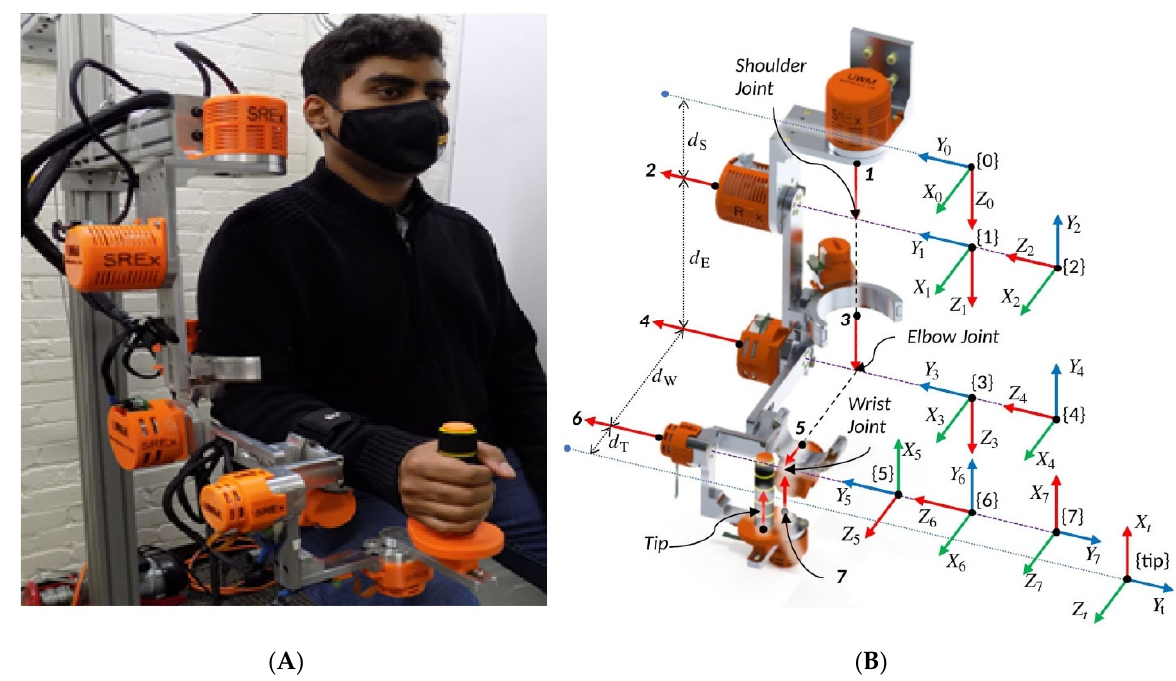
Figure 2. ( A ) SREx maneuvered by a healthy subject. ( B ) Link frame assignment on SREx’s model.